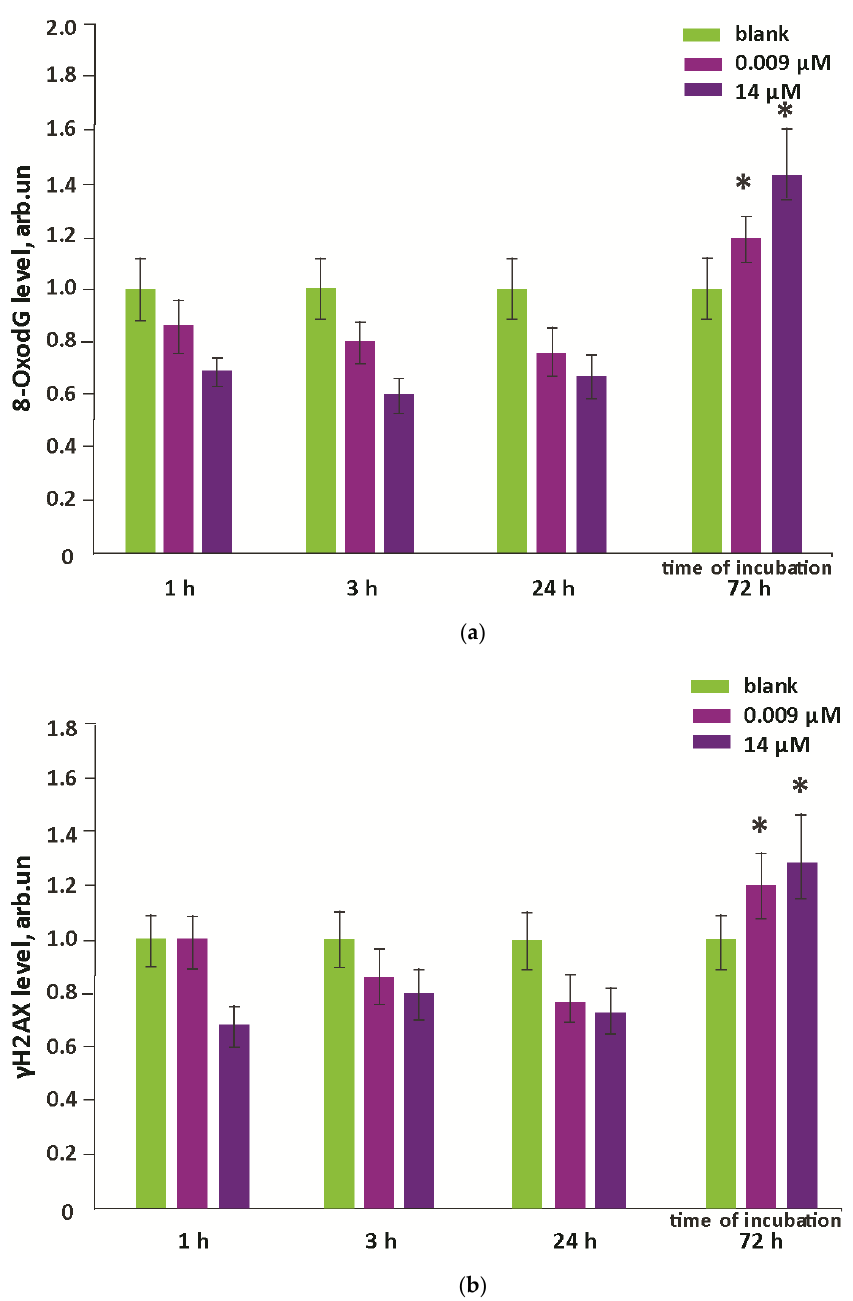
Figure 7. Histograms of DNA oxidation marker 8-oxyguanosine ( a ) and phosphorylated histone form in H2AX ( b ) in HELFs after incubation with F1 (medians are given). Significant differences with the control by the Mann − Whitney test ( p < 0.01) are denoted by “*”.